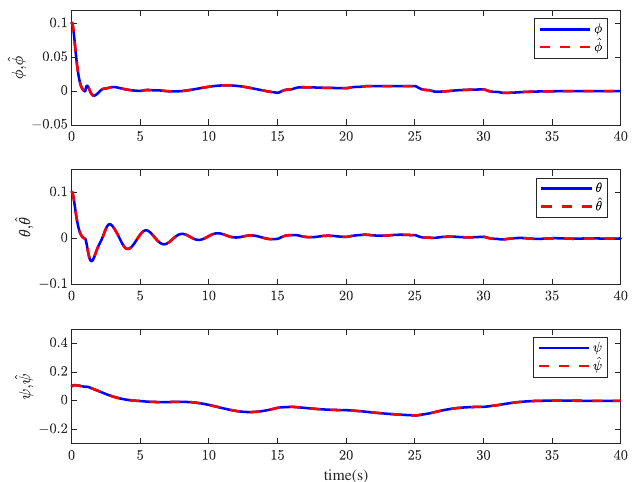
Figure 2. The actuator fault estimation errors e f